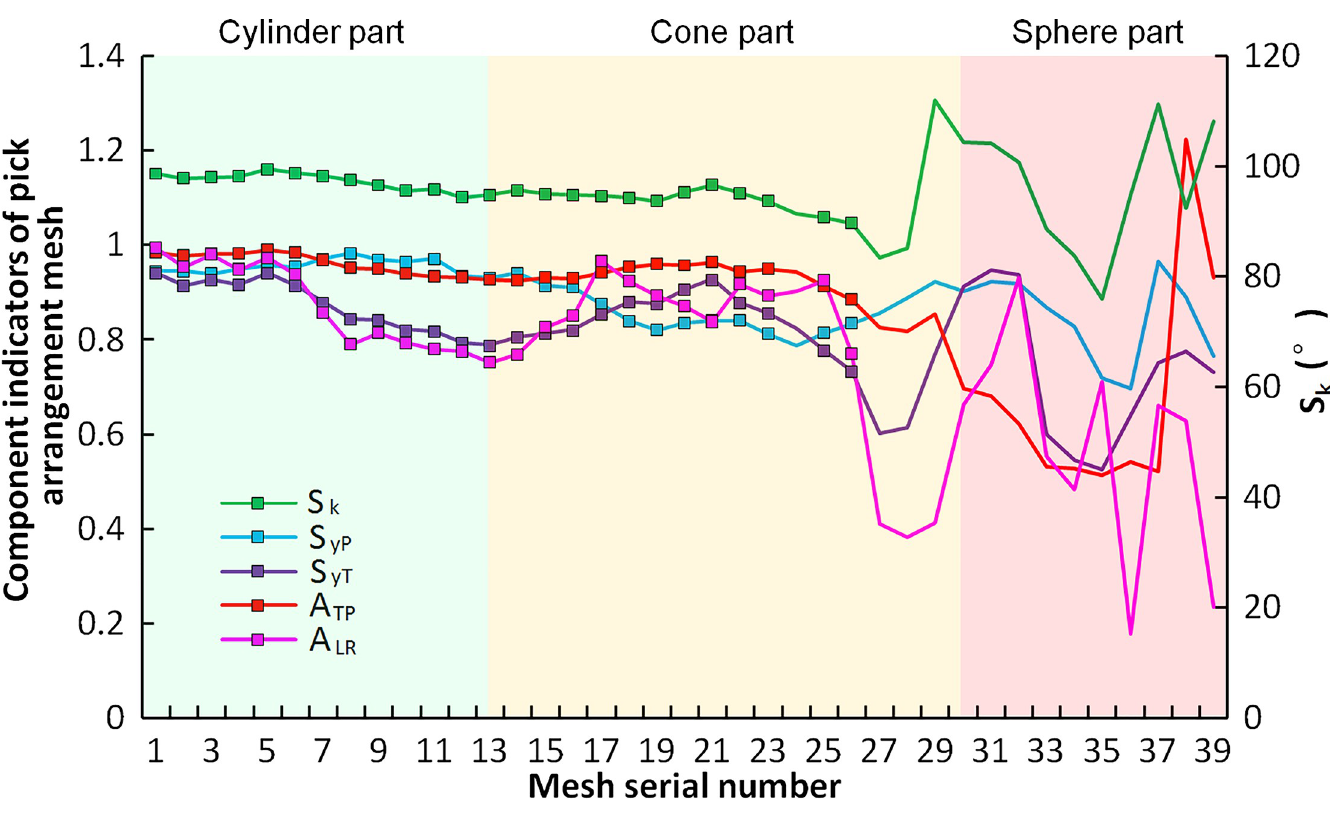
Fig 16. TMR indicators of the CH51 cutting